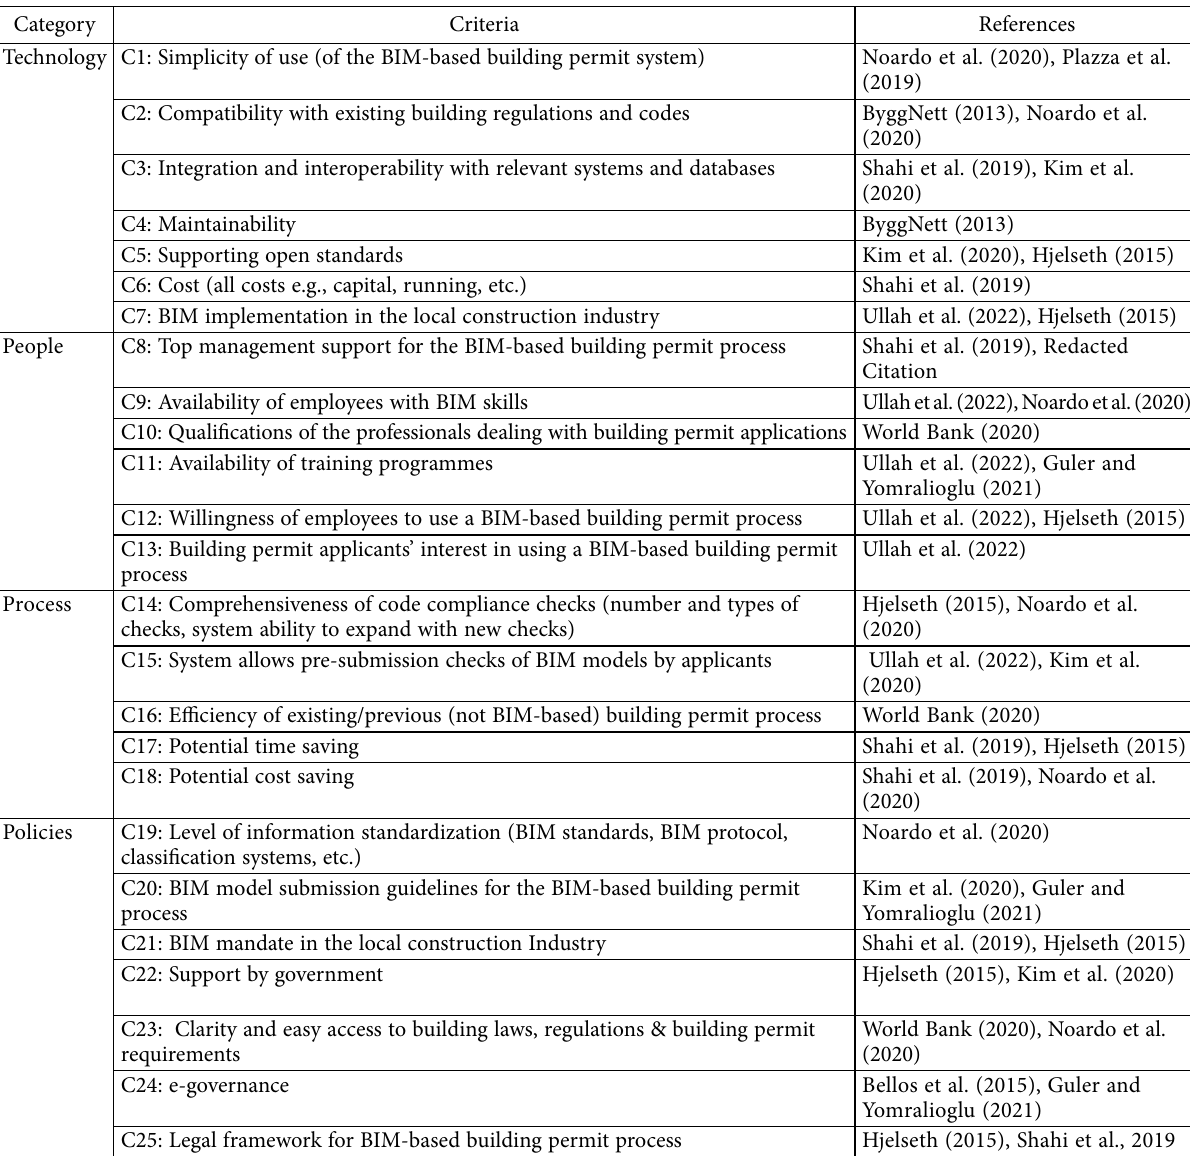
Table 1. Criteria for readiness assessment for BIM-based building permit